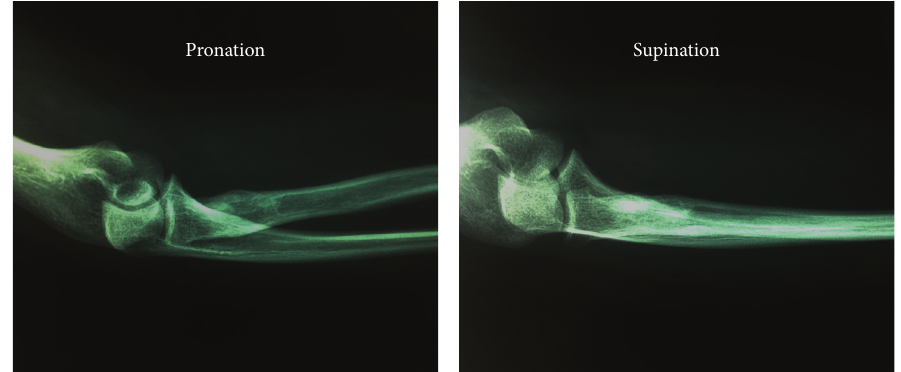
Figure 3: Radiograph images of the patient’s elbow in pronation and supination, 8 years postoperatively with no signs of